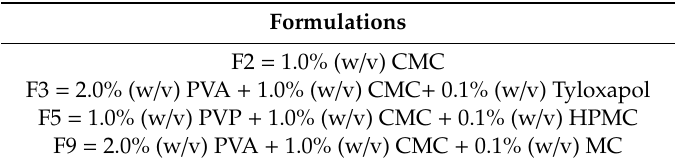
Table 1. Preliminary nepafenac aggregate formulations. All contain a mixture of 15% (w / v) γ -CD and 8% (w / v) HP β -CD in aqueous solution